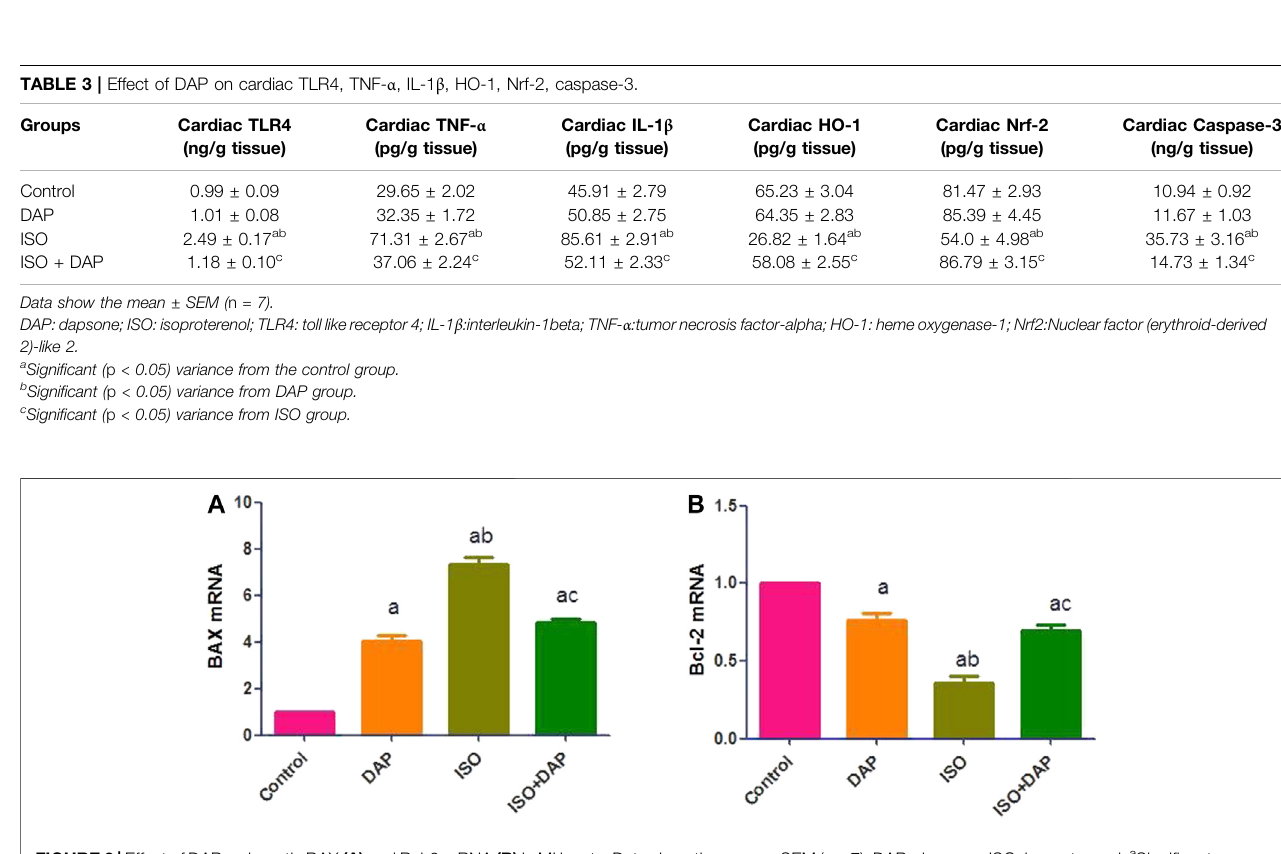
Frontiers in Pharmacology |